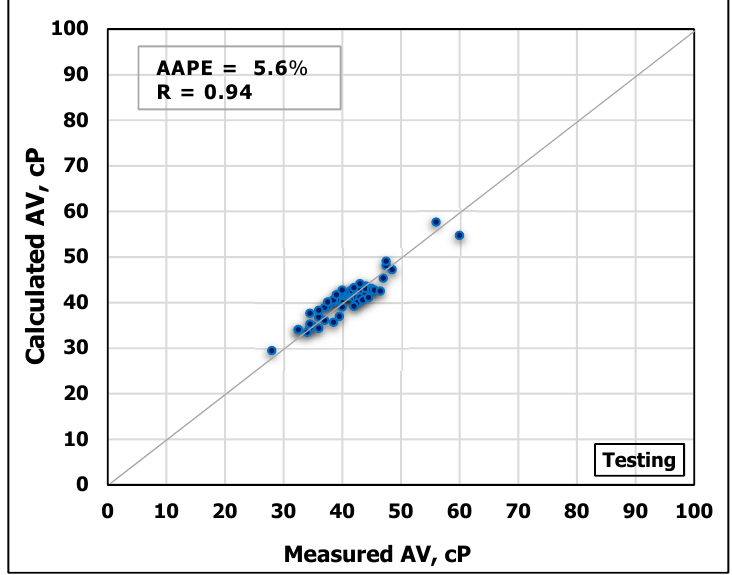
Figure 10. Measured AV vs. Predicted AV from the ANN model for the testing process.